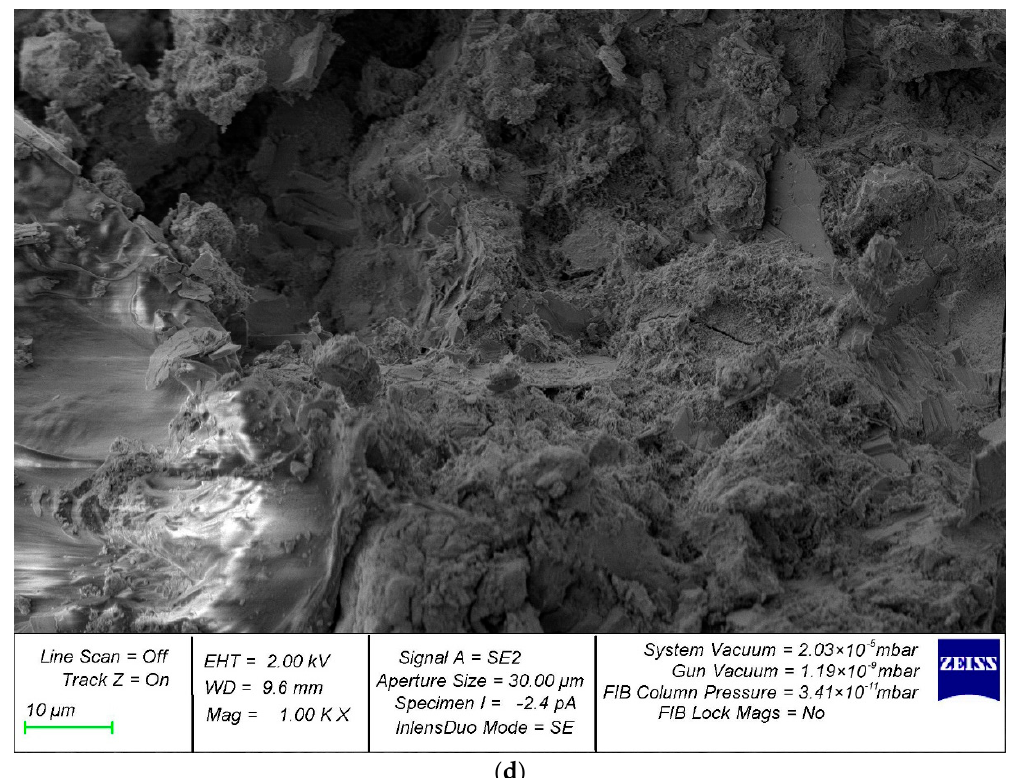
Figure 8. Photographs of the microstructure of a fiber-reinforced sample with magnification: ( a ) 100×; ( b ) 300×; ( c ) 500×; and ( d ) 1000×.